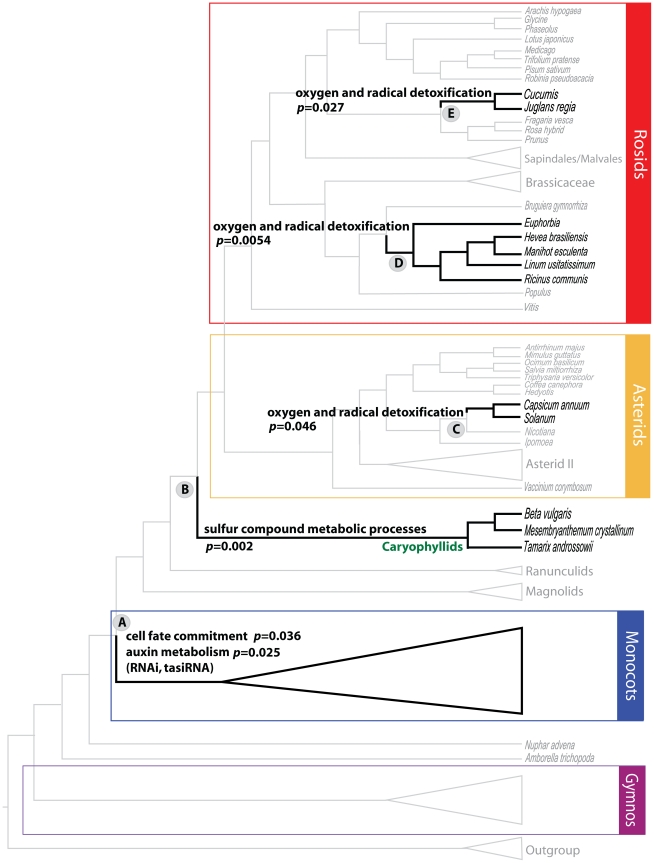
Select Overrepresented GO/MIPS Categories of Genes with Positive PBS at Major Nodes.There are statistically higher numbers of genes belonging to these GO/MIPS categories with positive support for the specific clades, implying that these genes may have special functional importance to the evolution of the corresponding clades. Only gene categories mentioned in the main text are shown. For a full list of overrepresented categories in each node see Table S3.